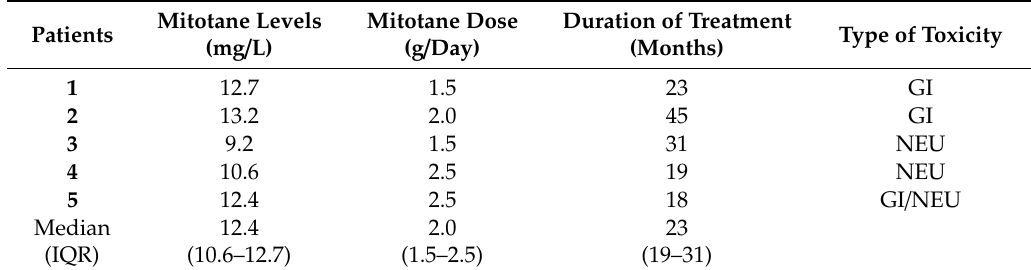
Table 2. Characteristics of mitotane treatment at the time of permanent discontinuation for toxicity. Legend: GI = gastrointestinal, NEU = neurological.